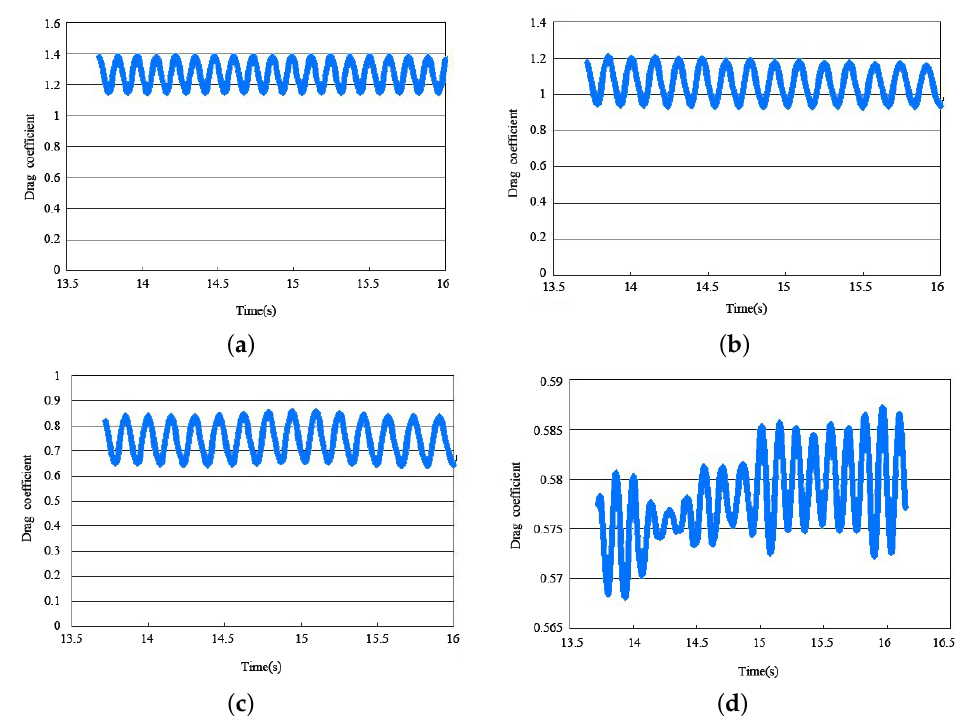
Figure 12. Variation curves of the drag coefficient of the SCR with time at different underwater depths: ( a ) drag coefficient curve at 1 m underwater; ( b ) drag coefficient curve at 2 m underwater; ( c ) drag coefficient curve at 3 m underwater; ( d ) drag coefficient curve of the entire